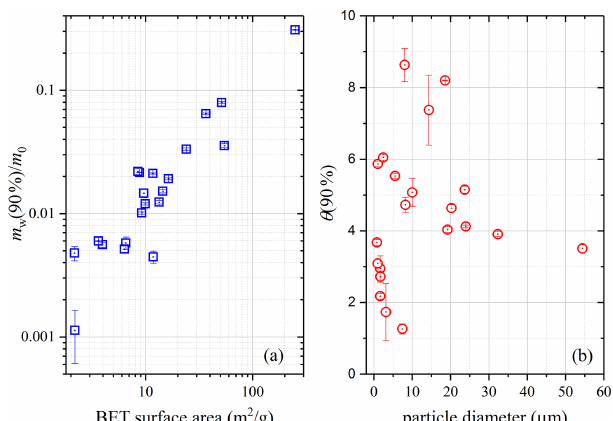
Figure 11. (a) The dependence of m w (90%) /m 0 (mass ratios of ad- sorbed water to the dry mineral at 90%RH) on BET surface areas; (b) the dependence of θ (90%) (surface coverages of adsorbed water at 90%RH) on average particle